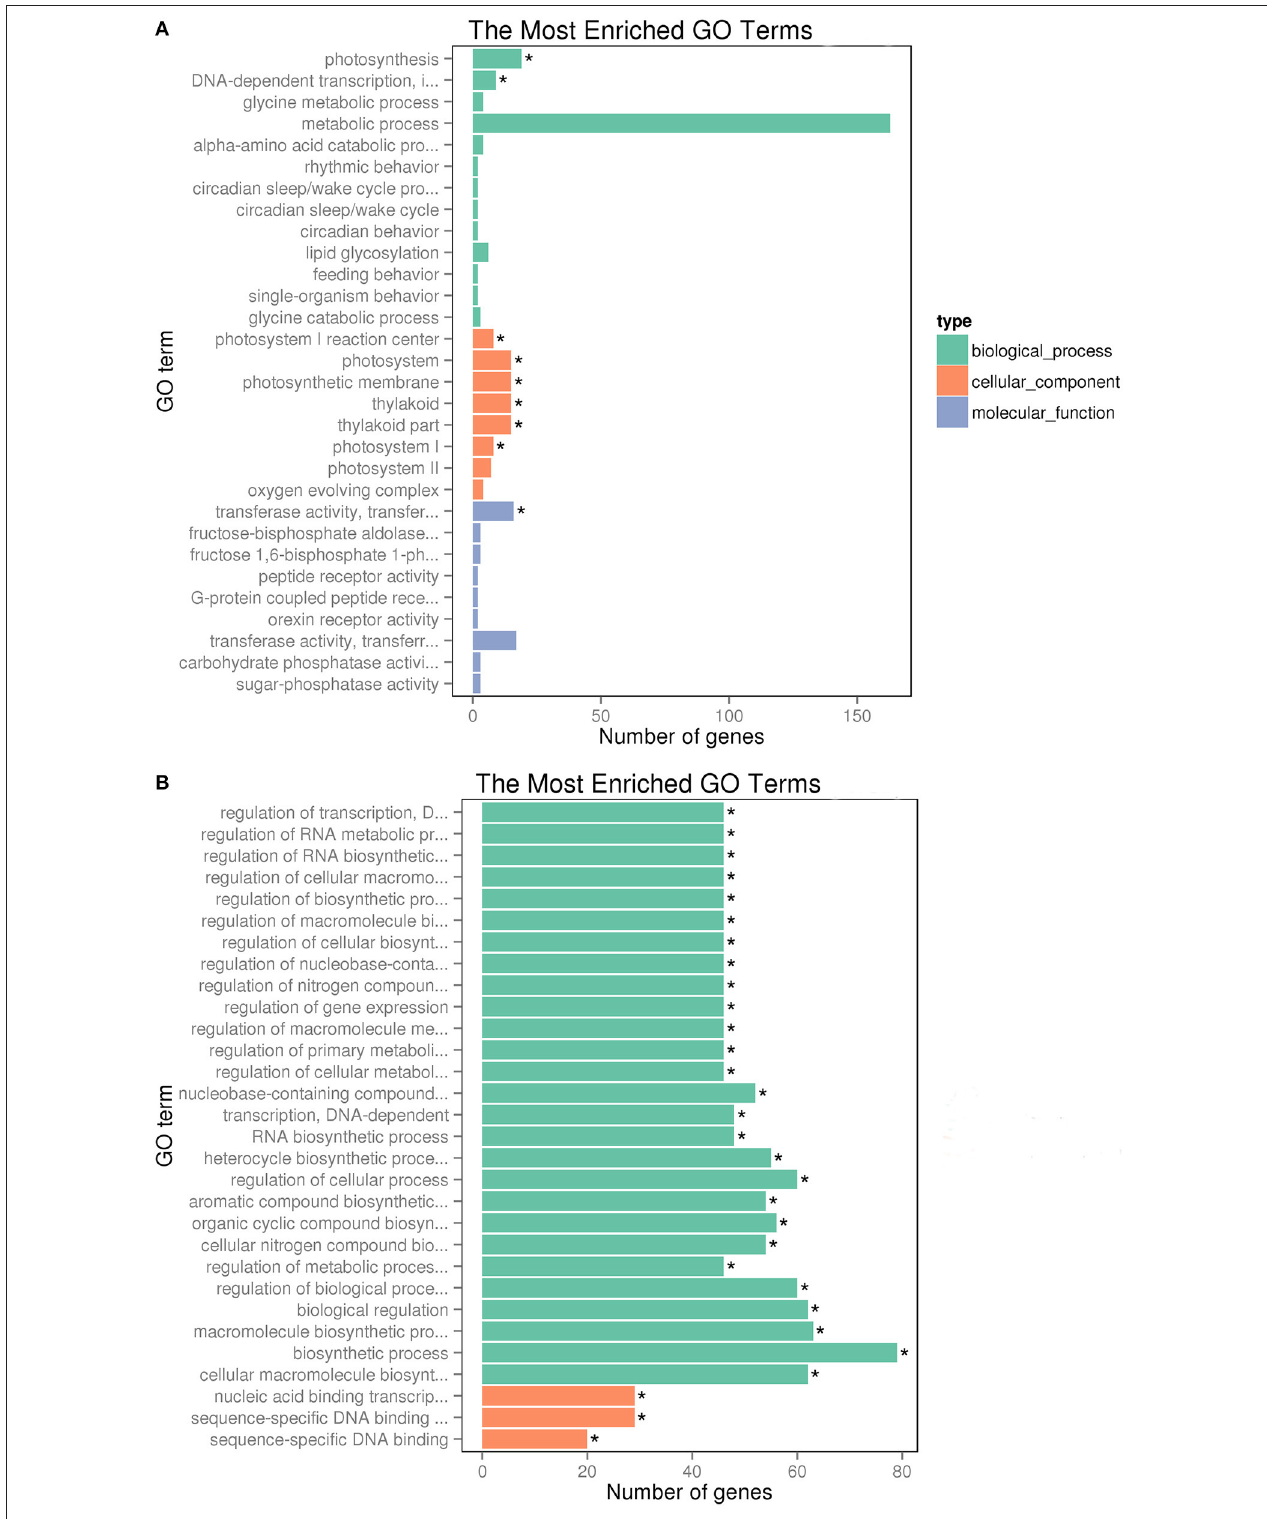
FIGURE 3 | GO enrichment analysis of DEGs between Chill and Chill + EBR treatment. (A) up-regulation; (B) down-regulation. The 30 most enriched GO terms are shown. Asterisks indicate significantly enriched GO terms ( q < 0.05).